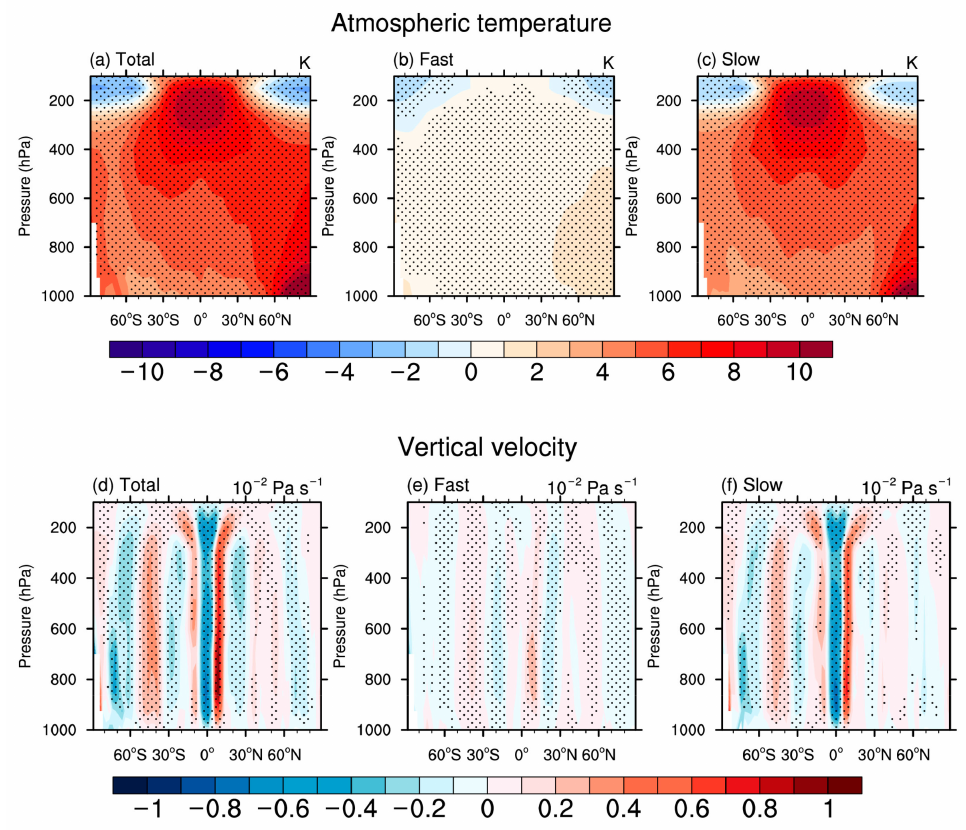
Figure 10. ( a , d ) Total, ( b , e ) fast, and ( c , f ) slow responses of global zonal mean ( a – c ) atmospheric temperature (unit: K) and ( d – f ) vertical velocity (unit: 10 − 2 Pa s − 1 ). Black dot represents that at least 8 models agree with the sign of